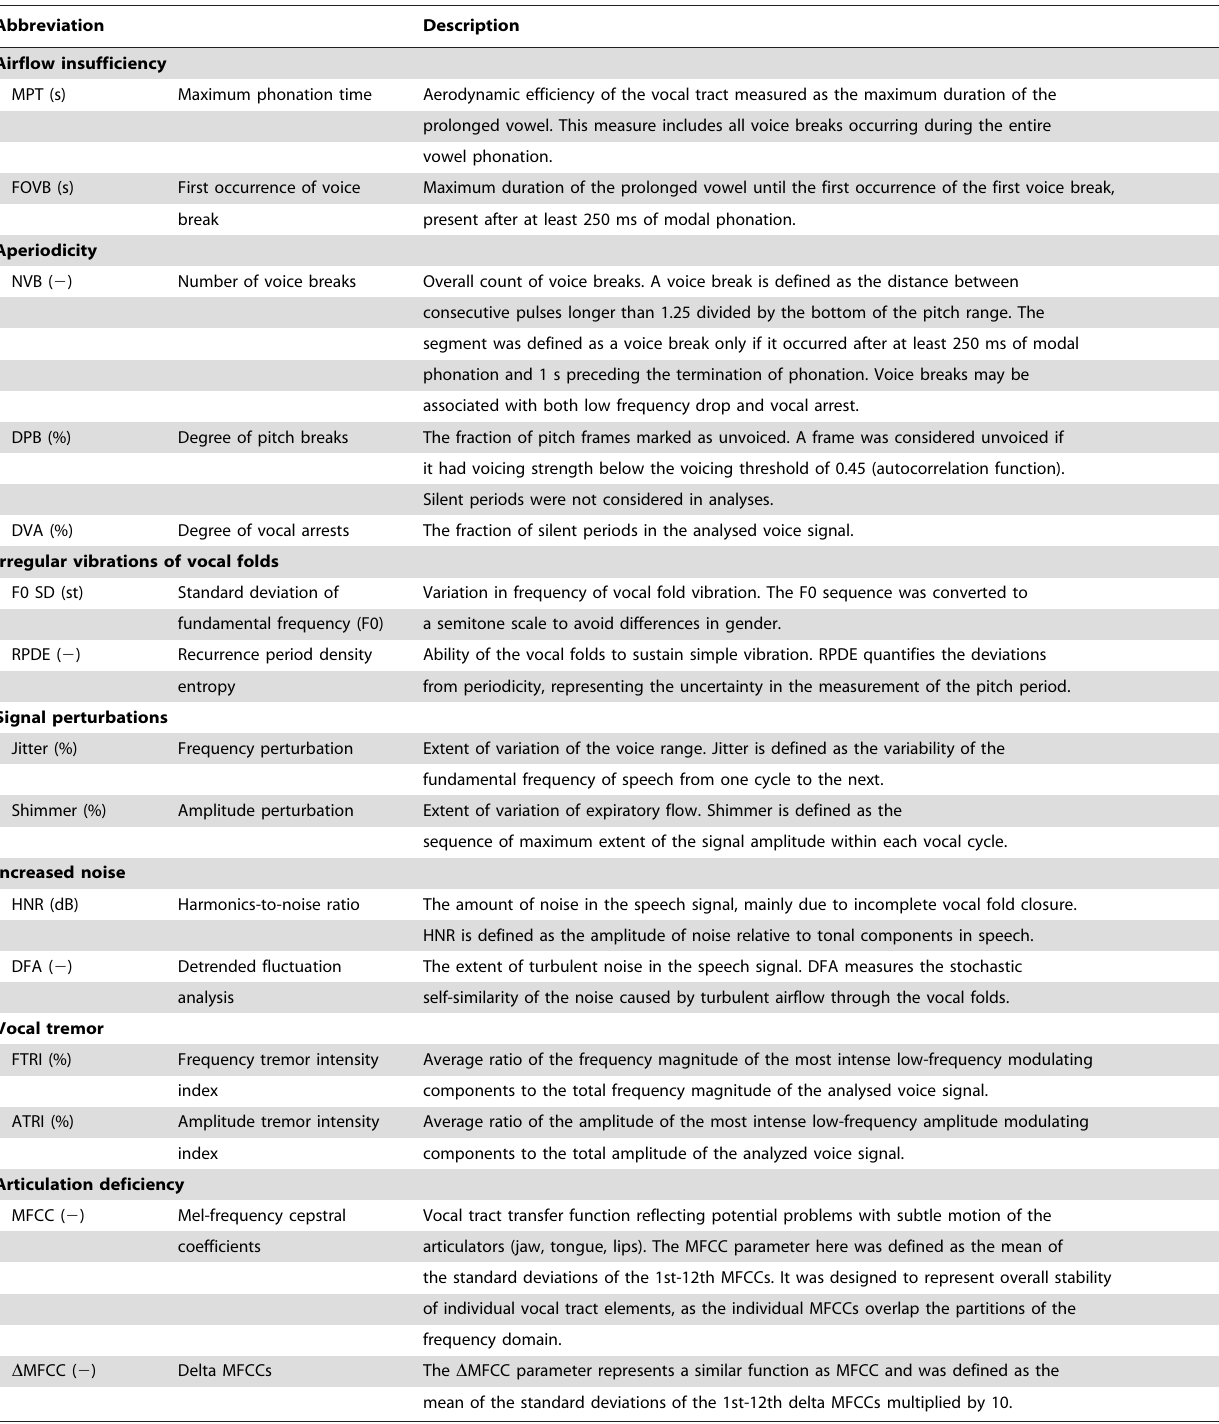
Table 2. Overview of applied phonatory